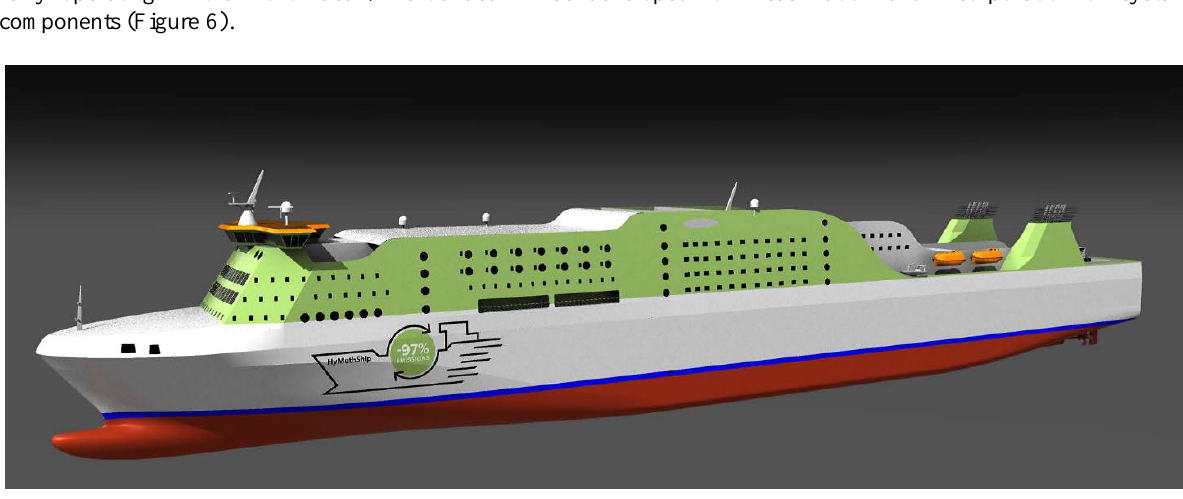
Figure 6. HyMethShip case study vessel